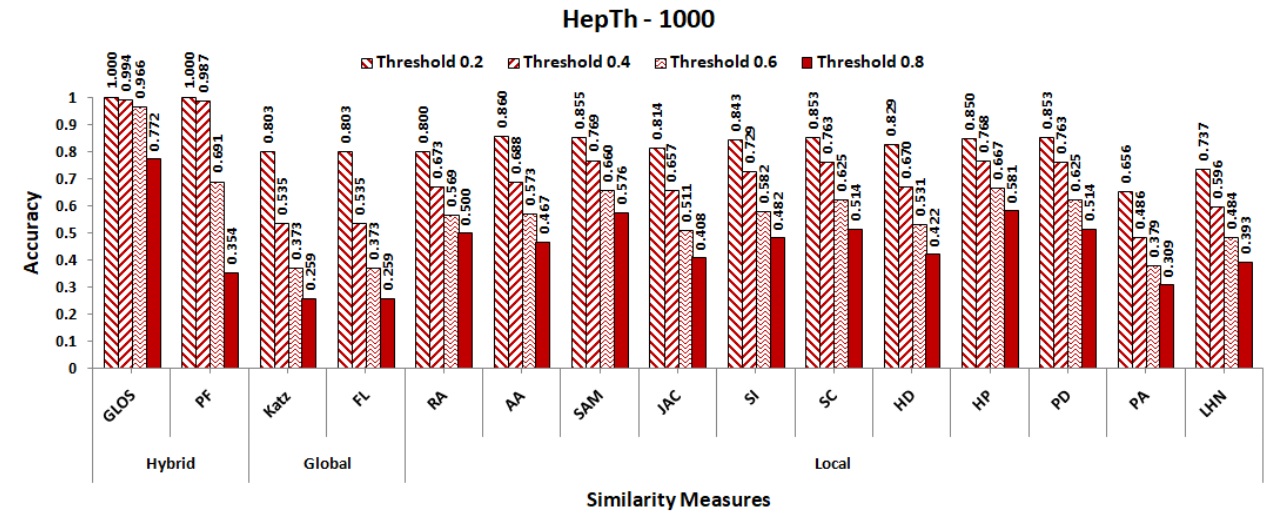
Figure 19. Comparisons of similarity measures on HepTh-1000 edge list from HepTh dataset